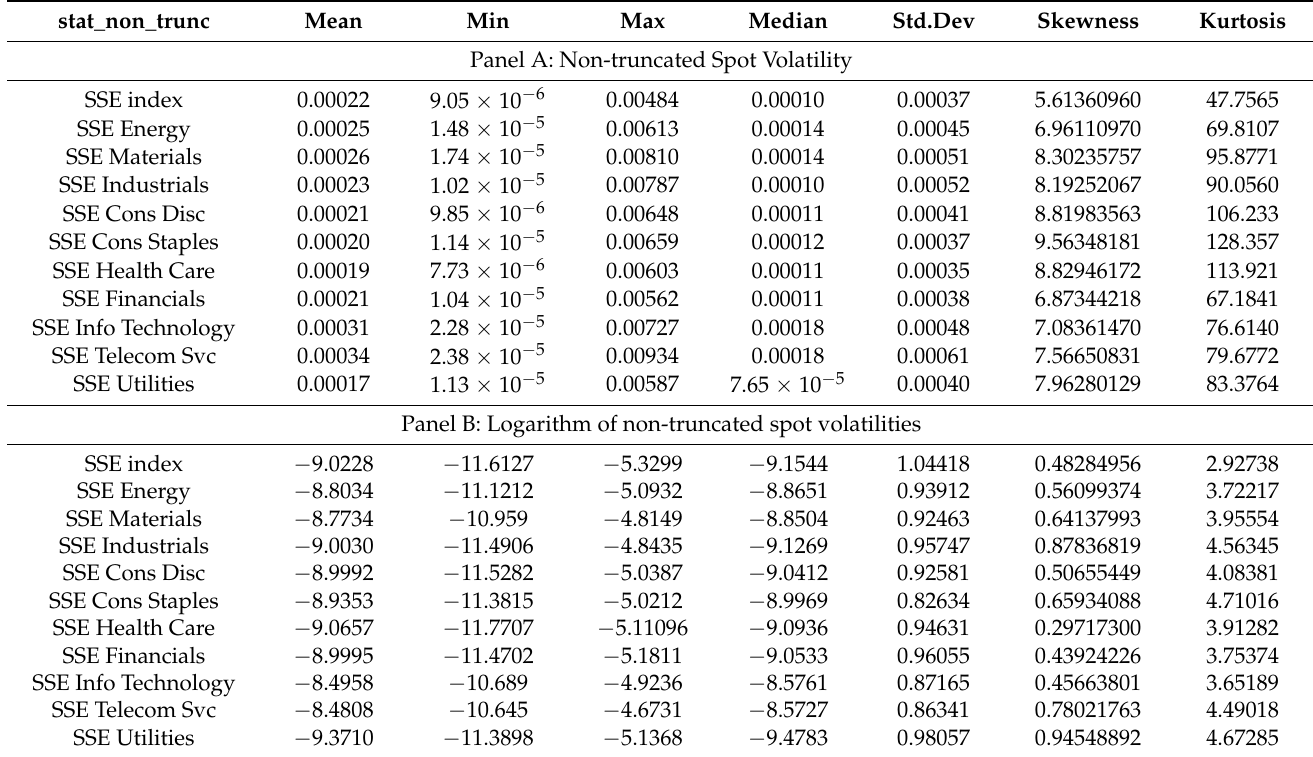
Table 3. Descriptive statistics for the non-truncated spot volatility and its